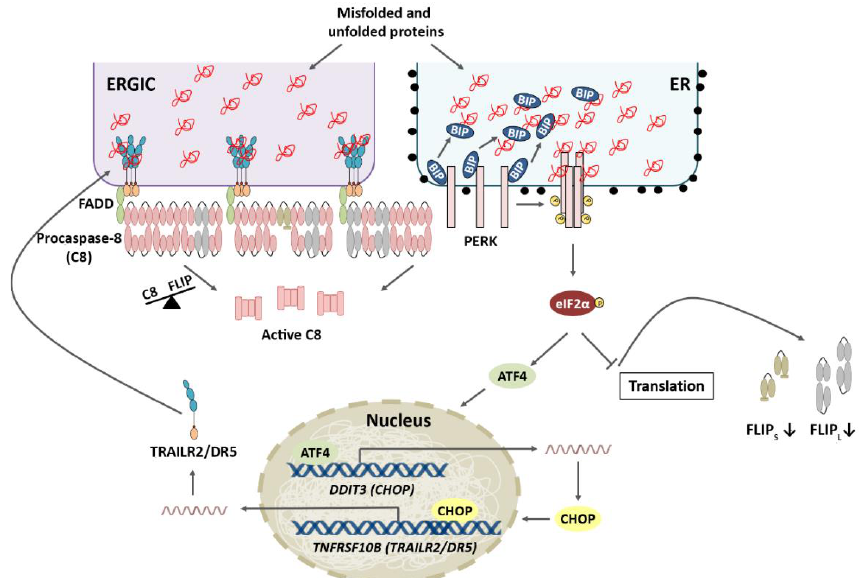
Figure 4. TRAILR2/DR5 upregulation and FLIP downregulation are both required for ER stress- induced apoptosis. ERGIC: ER-Golgi intermediate compartment. CHOP-induced TRAIL-R2/DR5 upregulation and a decrease in the expression levels of cFLIP proteins upon ER stress, which alters the caspase-8/FLIP ratio, facilitate caspase-8 activation and